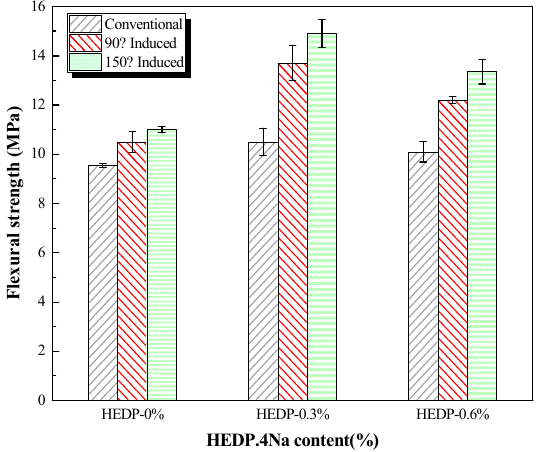
Figure 4. Flexural strength of 28d FR-AASC.